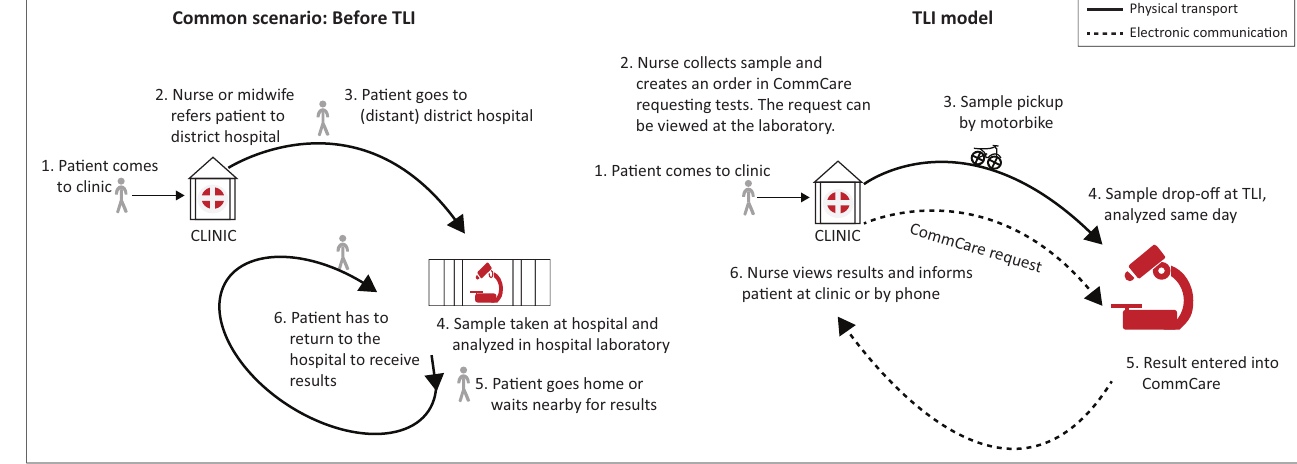
FIG URE 1: The Tropical Laboratory Initiative